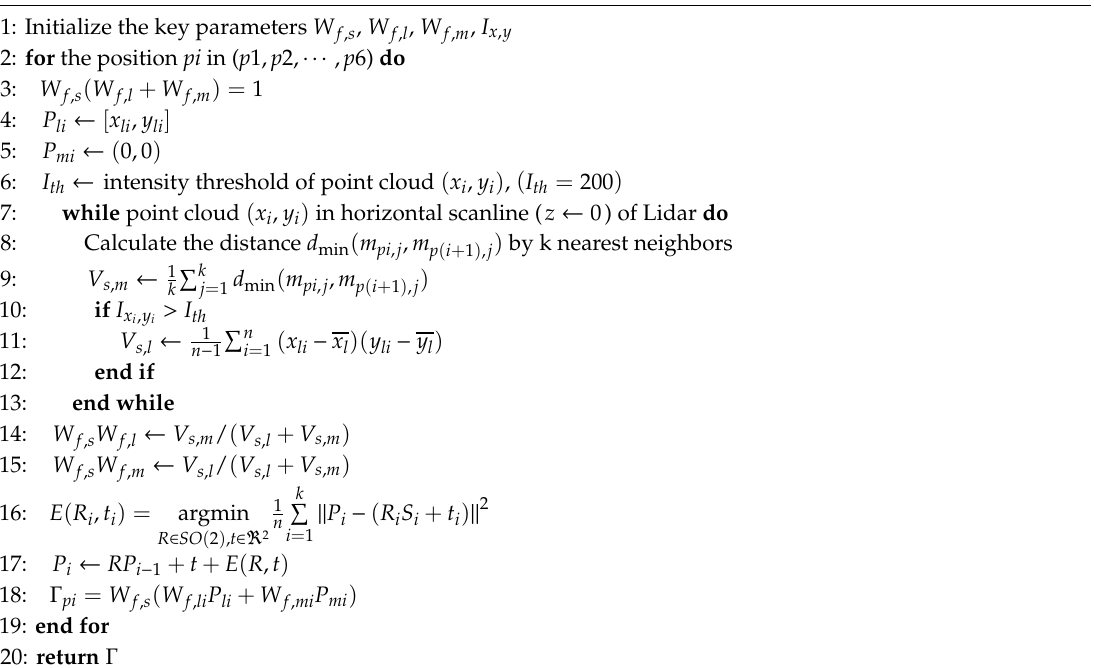
Algorithm 1 Robust localization of mobile robot based on adaptive weighting